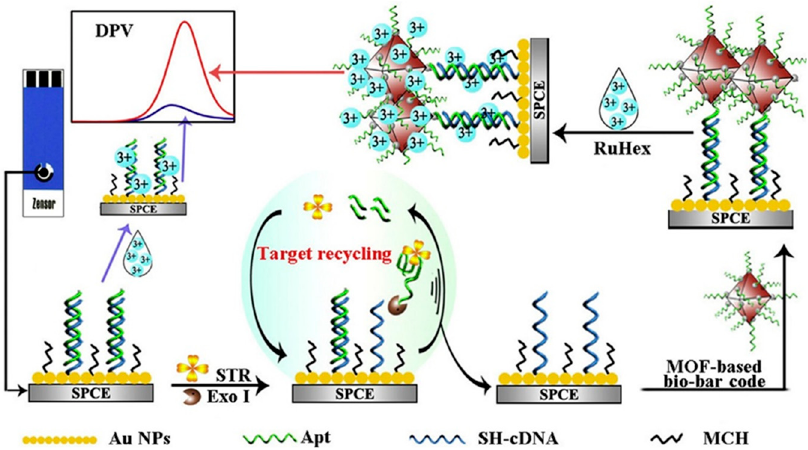
Figure 4. Schematic illustration of the fabrication process of a MOF-based bio-barcode and enzyme-assisted target recycling amplified biosensor for the determination of STR. Reprinted from [59] with permission.